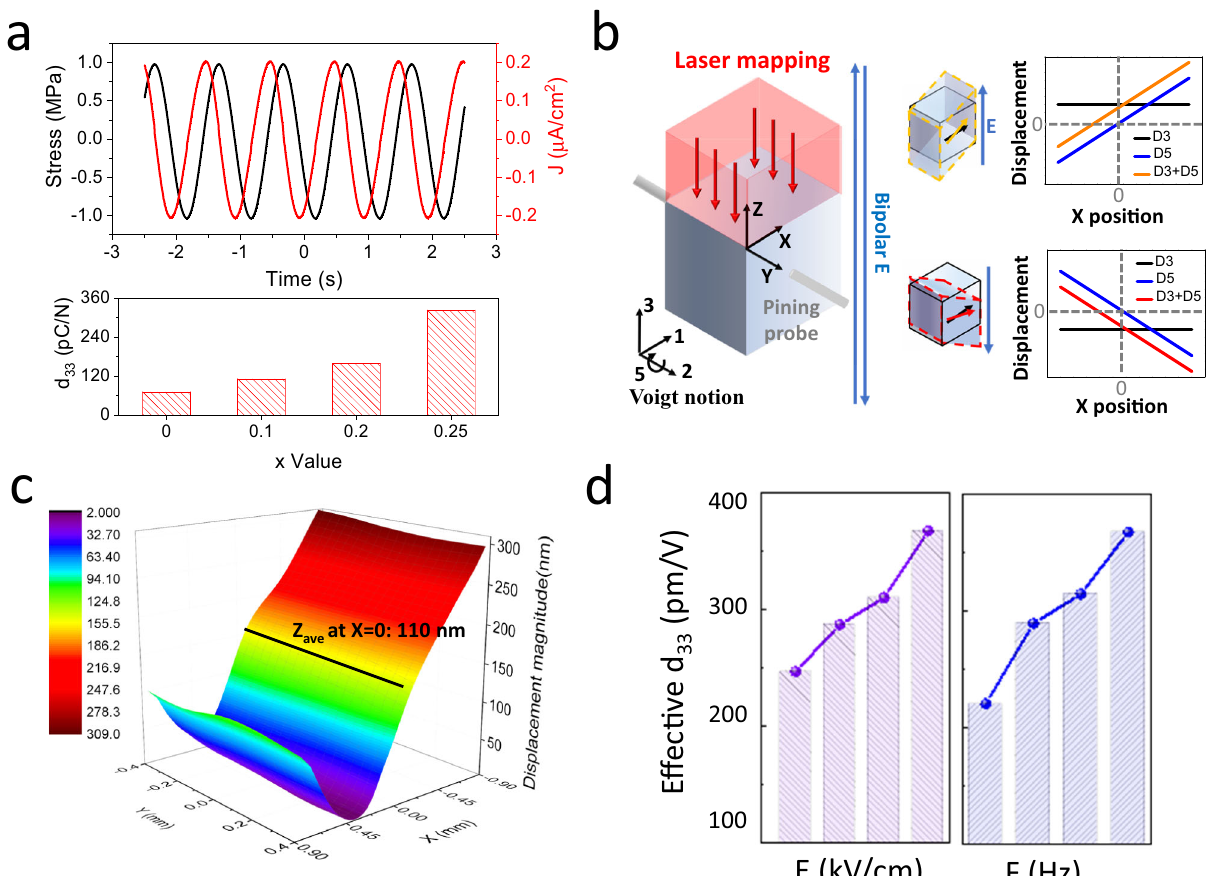
Fig. 2 | Piezoelectric properties. a Stress (1Hz, 2MPa) and generated current waveformsof x =0.25crystal(upper)andthe d 33 ofselectedcompositionsobtained under the same stress (lower). b Experiment setup of converse d 33 measurement (left), simulated LiH 3 (SeO 3 ) 2 (piezoelectric materials with the same Cc space group) crystal deformation (middle) and corresponding displacements of top surface line, where the normal ( S 3 ) and shear strain ( S 5 ) offset each other (see Fig.2bandSupplementaryFig.7b – e,Xisthecoordinateaxisparallelto [100] orientation). The d 33 contribution can be extracted at X = 0 line,